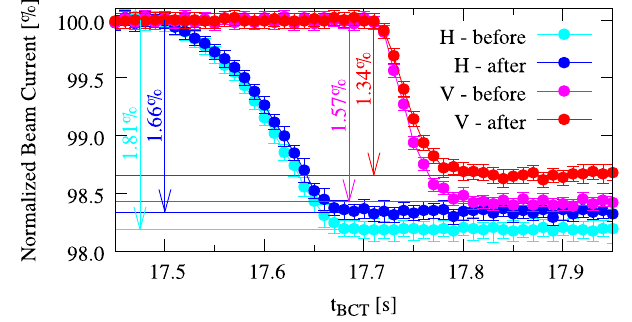
FIG. 9. Normalized BCT signals during regular scraping before (light colors) and after (dark colors) the test of the horizontal (blueish curves) and vertical (reddish curves) blades. Each curve was obtained as an average of a few consecutive fills. The error bars refer to the maximum between the dispersion of data and error propagation.